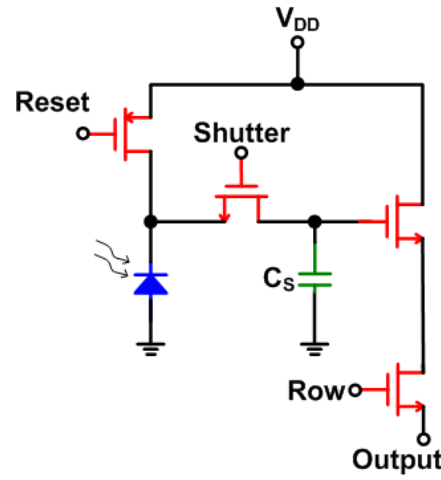
Figure 7. Simple 4-T APS with an analog storage